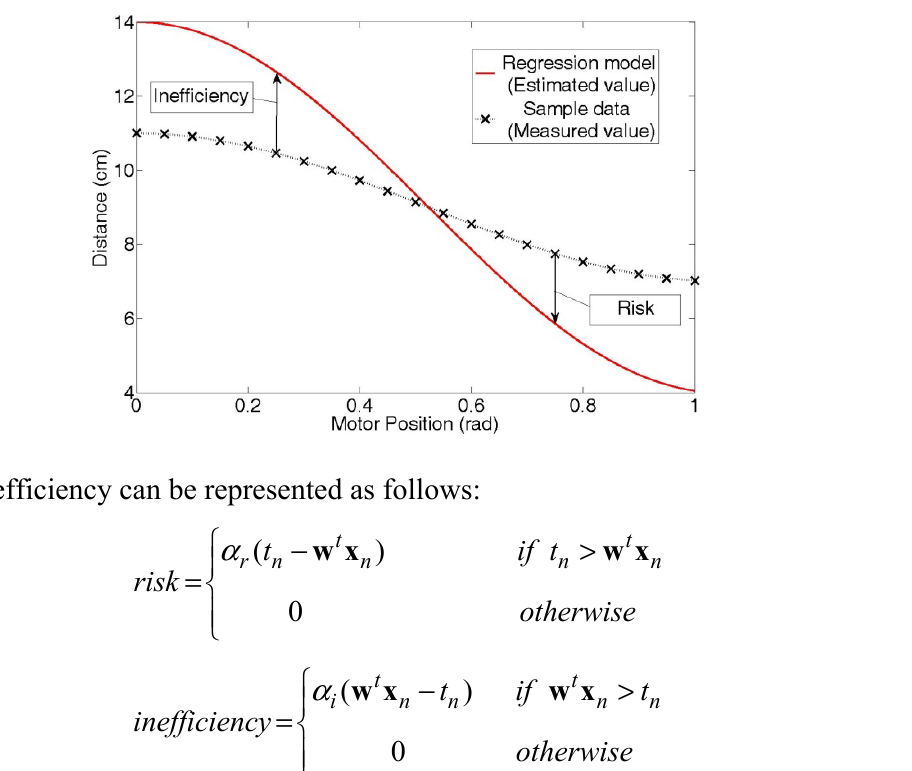
Figure 6. Risk and